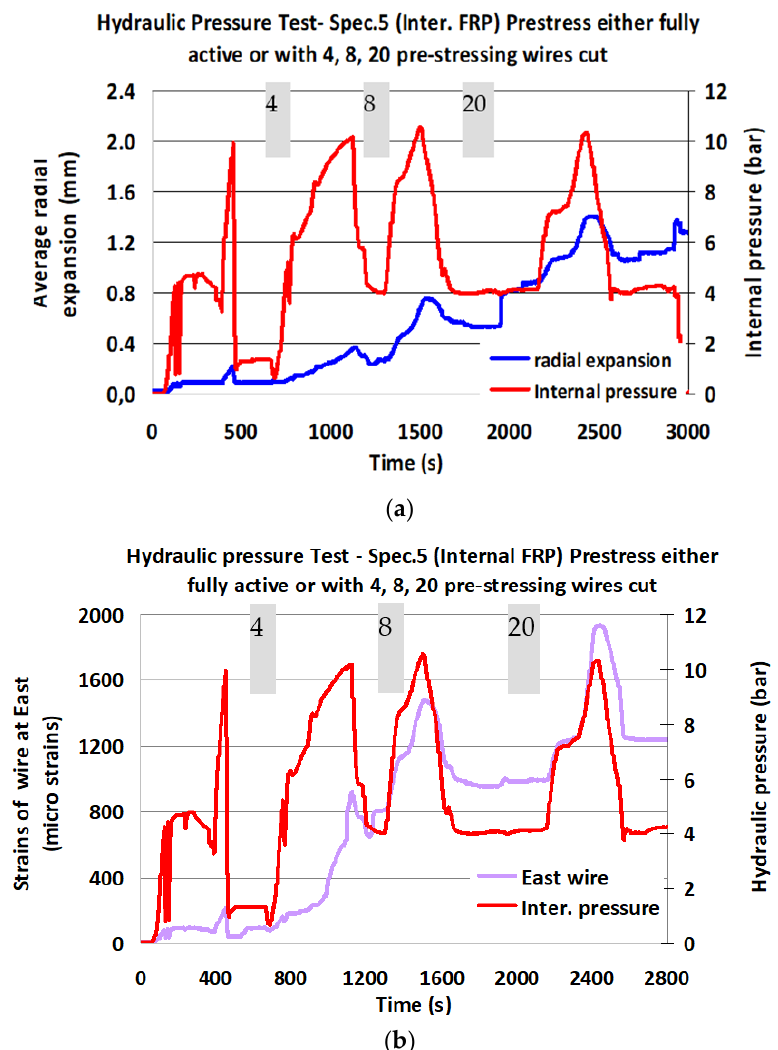
Figure 24. ( a ) Variation in the average radial expansion versus internal pressure for the whole duration of the test. The time and the number of cut wires are also indicated with the grey stripes. ( b ) Variation in wire radial strain versus internal pressure for the specimen with cut wires (4, 8 and 20). The time and the number of cut wires are also indicated with the grey stripes.